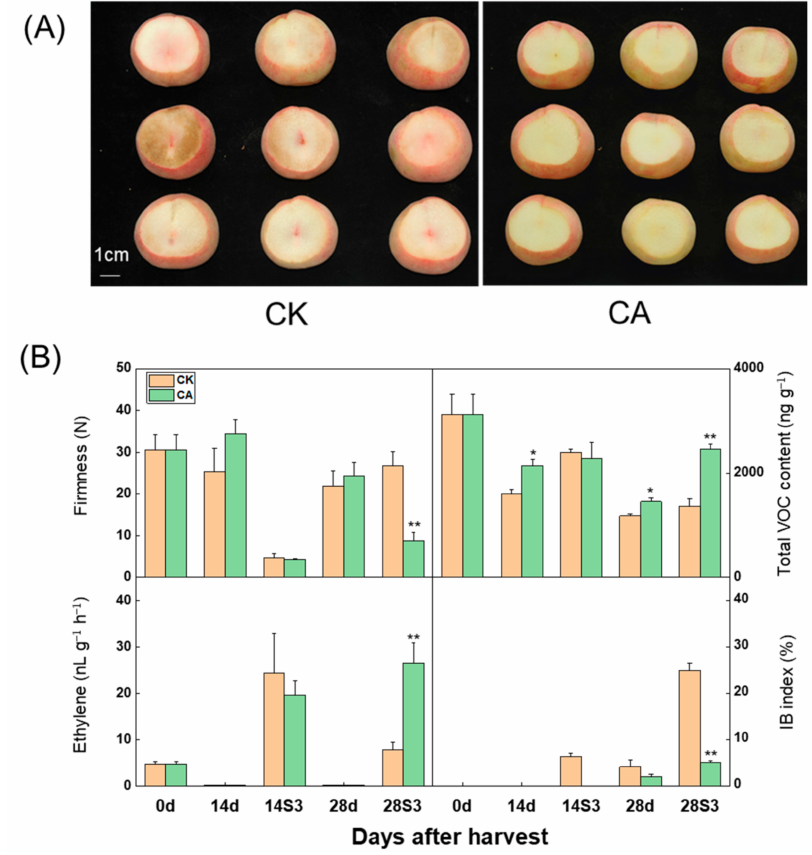
Figure 1. Physiological changes of peach fruit under CA treatment during the cold storage and shelf-life. ( A ) Photos of peach fruit under CA treatment after 28 d cold storage with 3 shelf-days at 20 ◦ C; ( B ) Changes of the firmness, ethylene emission rate, total volatile organic compounds (VOC) and IB index of peach fruit under CA treatment. Data are expressed as the means ± standard error of three biological replicates, the * indicated the statistical significance of the two samples with the unpaired Student’s t -test ( * p < 0.05, ** p < 0.01. 28S3CK: the first number represent days after postharvest storage, S, means shelf-life, 3 means the days during